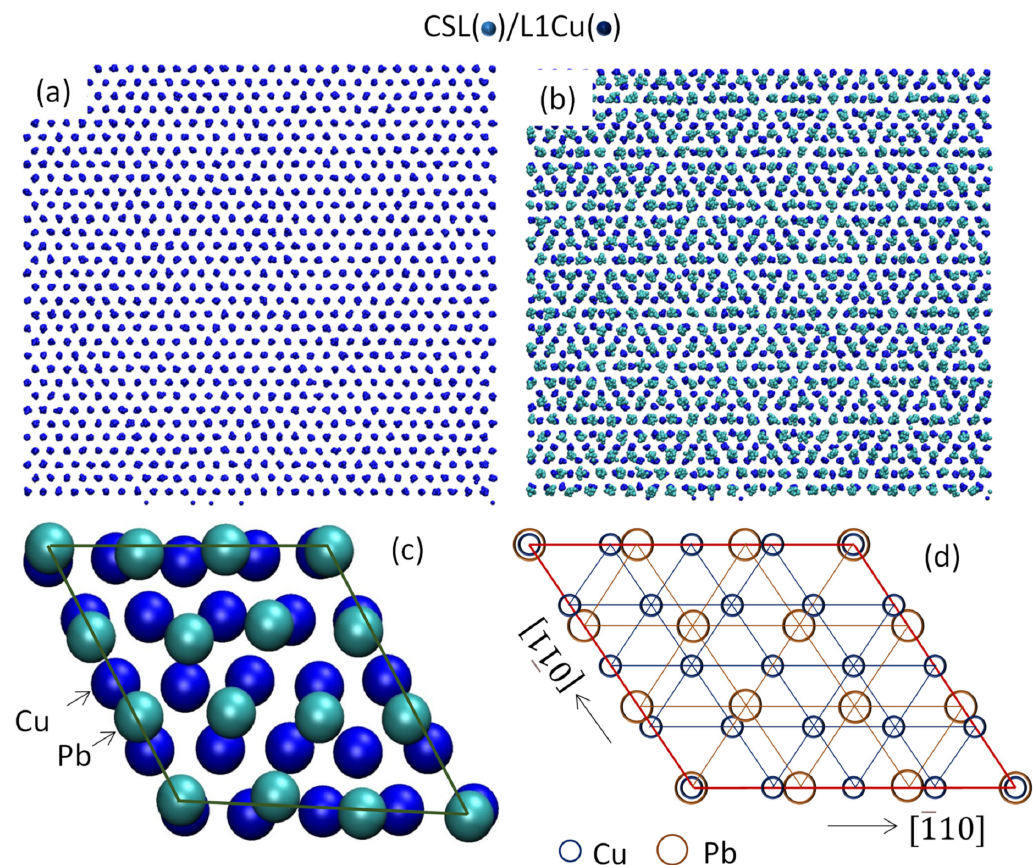
Figure 3. A new substrate is produced by prenucleation in the Pb( l )/Cu( s ) system equilibrated at 625 K ( T l = 618 K) [39]. ( a ) Time averaged atomic positions showing a completely ordered Pb layer, which will act as the new substrate for heterogeneous nucleation; ( b ) time averaged atomic positions in the ordered Pb layer superimposed on that of the top layer of the Cu surface (L1Cu) showing that the ordered Pb layer ( a ) is a coincidence site lattice (CSL) relative to L1Cu; ( c ) snapshot of CSL/L1Cu showing the matching pattern in the CSL unit cell; and ( d ) schematic illustration of the CSL unit cell showing the matching rule, 3 d Pb = 4 d Cu , where d is the atomic spacing along the <011>